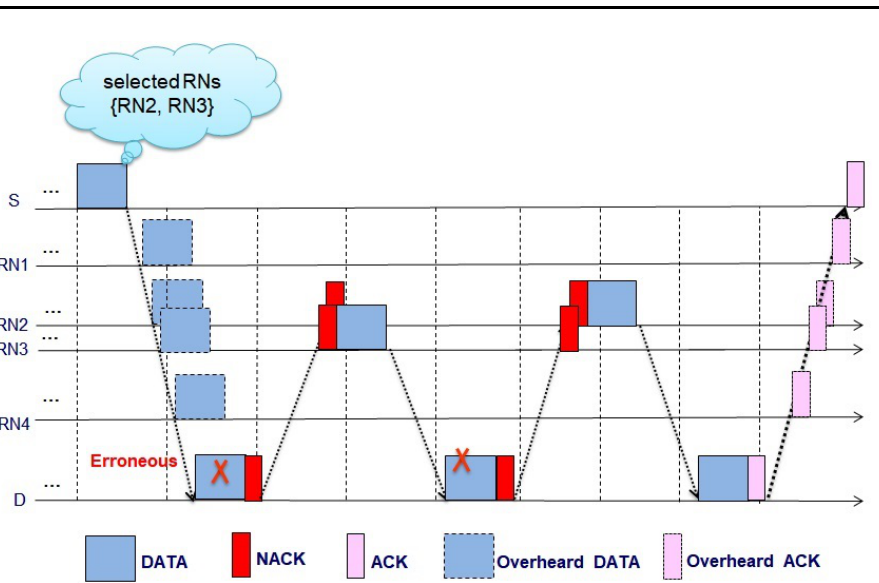
Figure 5. Data packet transfer in